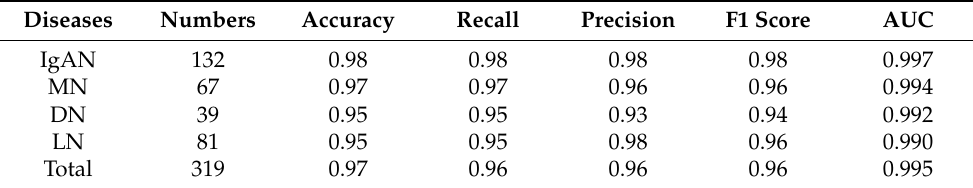
Table 1. Classification subnet performance in disease diagnosis based on non-blurred IF images.